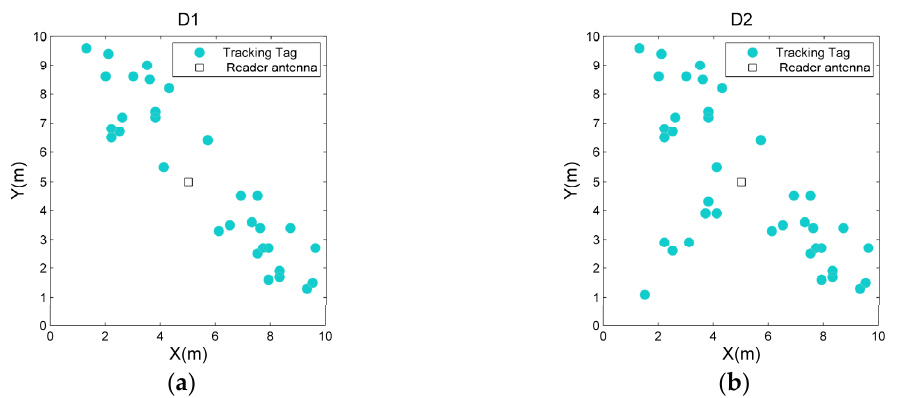
Figure 10. Diagram of two deployments with regard to the tracking tags. ( a ) D1 and ( b ) D2.